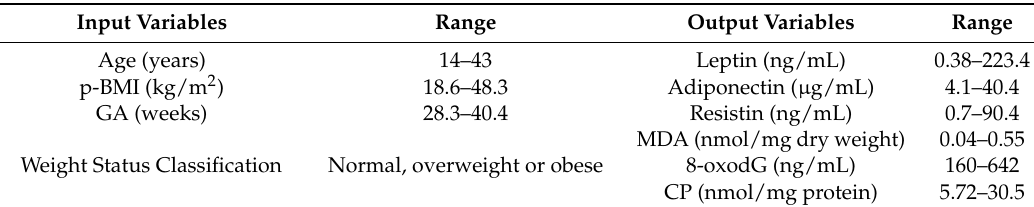
Figure 4. A representative network architecture of the maternal artificial neural network (ANN) model. The learning procedure used by ANN for the prediction at the third trimester of pregnancy of adipokine or oxidative stress marker concentrations in maternal blood (from 4 gestational variables: maternal age, p-BMI, weight status classification and gestational age), trained by the Levenberg–Marquardt optimization algorithm. The same architecture was utilized for adiponectin, leptin, resistin, carbonylated proteins, MDA and 8-oxodG values estimation. + and – indicate changing the weights and biases values to obtain the smallest error between exp and sim. Table 2. Input (clinical and anthropometric variables) and output (biochemical values) range conditions in the maternal ANN